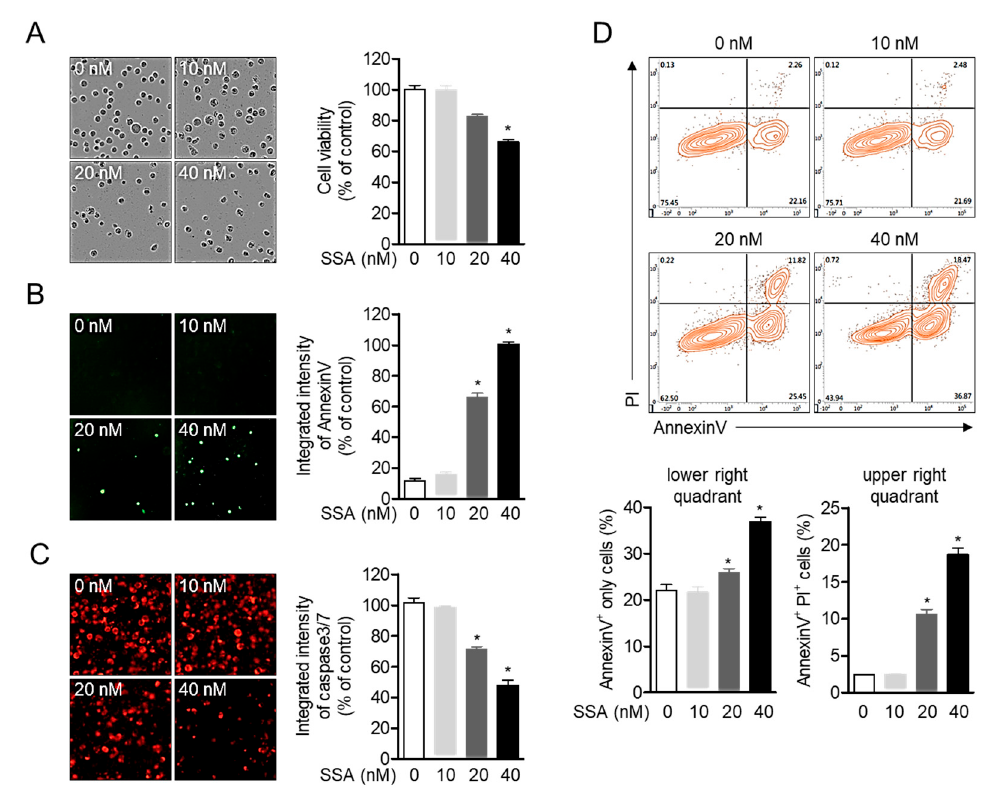
Figure 2. High concentrations of salinosporamide A are cytotoxic to T cells and leads to apoptosis. ( A – C ) DIC images ( A ), the expression of AnnexinV ( B ), or caspase3/7 ( C ) in Jurkat T cells obtained from the IncuCyte imaging system after incubation with the indicated concentration of salinosporamide A (0–40 nM) for 24 h. ( D ) The apoptotic population was identified by an AnnexinV/PI apoptosis assay, after incubation with the indicated concentration of salinosporamide A (0–40 nM). The mean value of three experiments ± SEM is presented. * p < 0.05 between control cells.